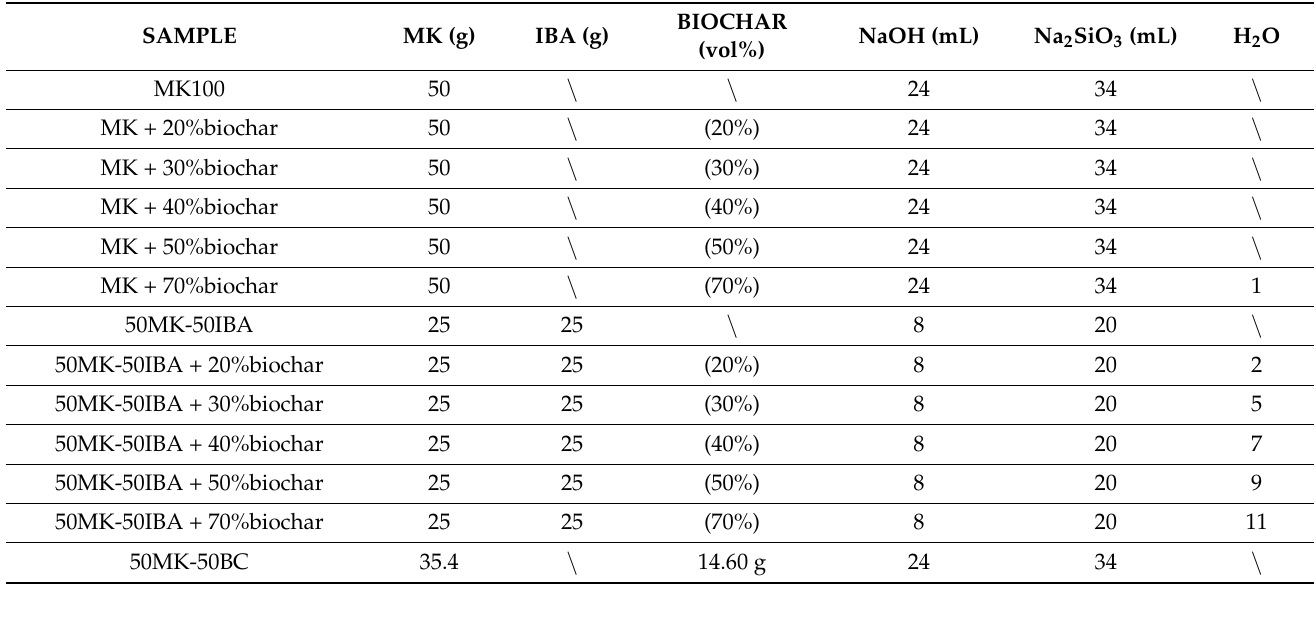
Table 1. Formulations of Series 1 and Series 2 samples (MK: Metakaolin; IBA: incinerator bottom ash; BC: Biochar in substitution).